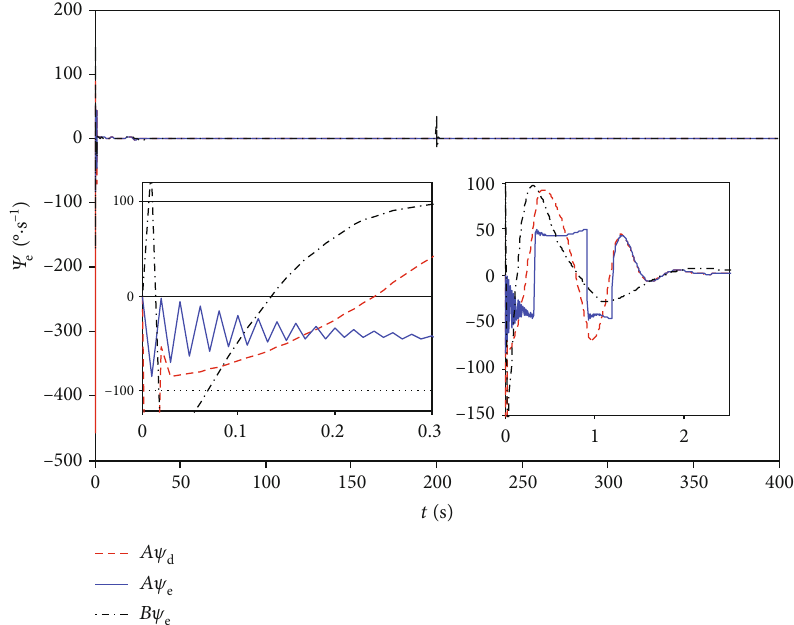
Figure 11: Curves of rate of elevator angular de fl ection.